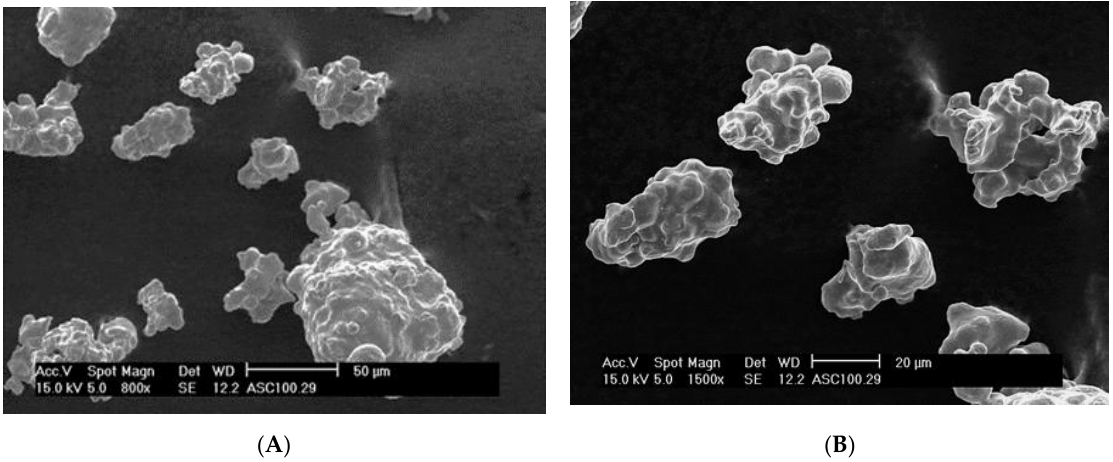
Figure 2. Clemen Scratch tester with a 4 kg load.